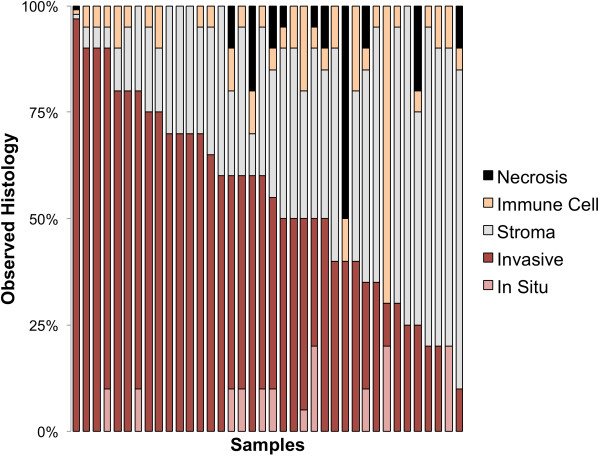
Histology examination. For each sample, the proportion of necrosis, immune cells, stromal cells, in situ tumor and invasive tumor is indicated.